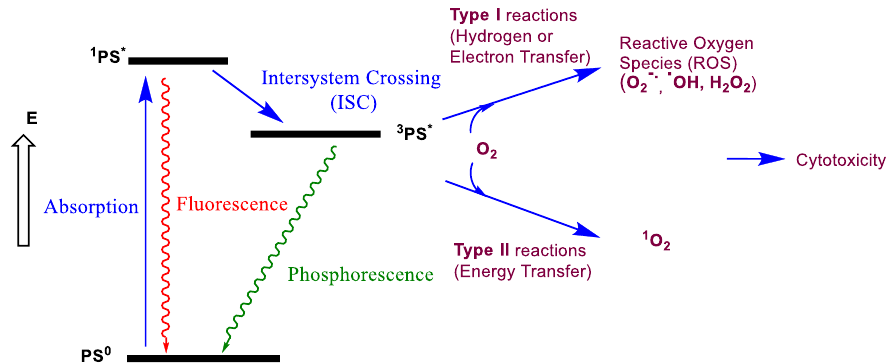
Figure 2. Mechanism of PDT represented by modified Jablonski diagram after administration of the photosensitizer [55,61].